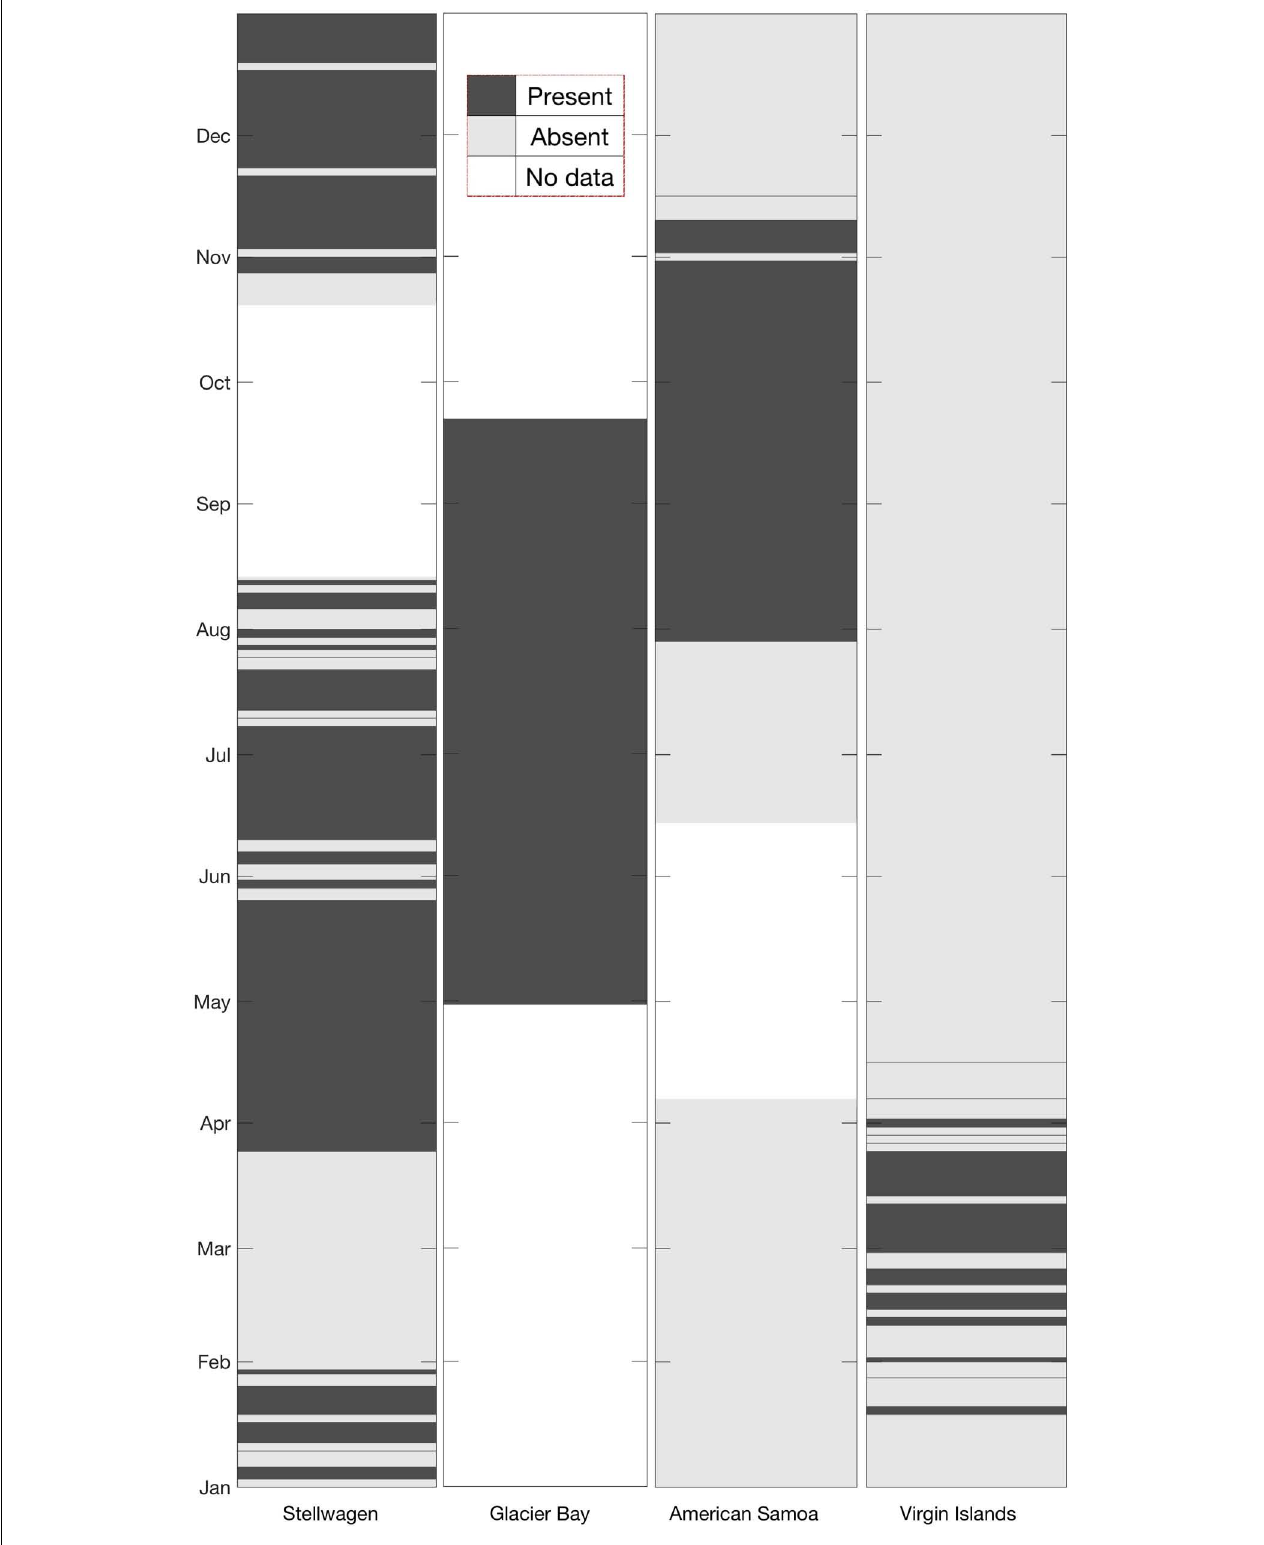
FIGURE 5 | Site-by-site comparison of monthly presence (dark gray shading) or absence (light gray shading) of humpback whale vocalizations. All available data were analyzed for the presence/absence of humpback whale vocalizations. White sections indicate data gaps at each site.